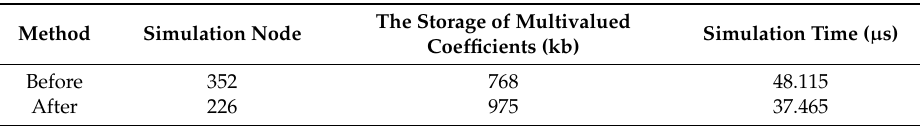
Table 4. Comparison of using the inlet and outlet unit